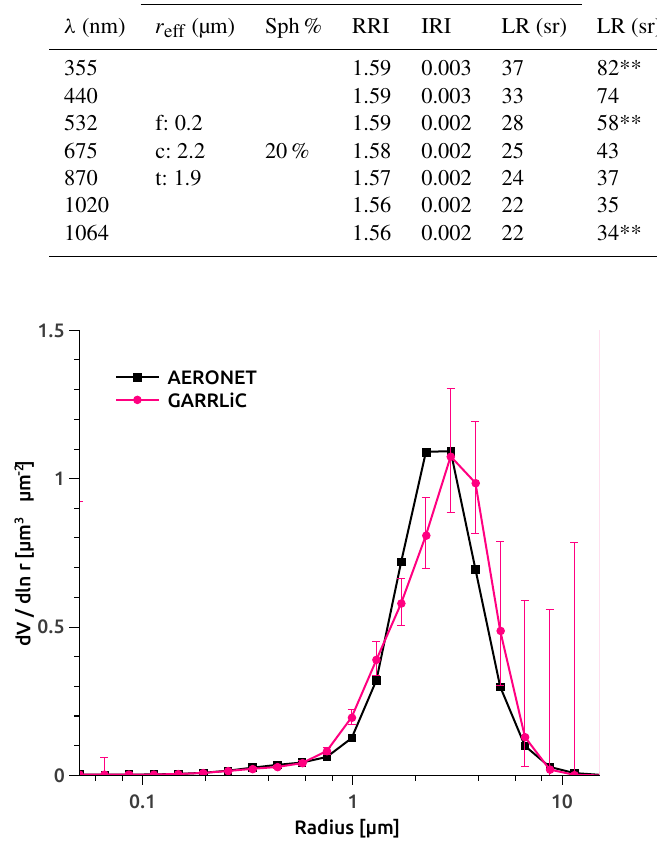
Figure 7. GARRLiC (pink) and AERONET (black) SD on 29 March 2015 (16:49UTC) over the Dakar site (AOD 440nm ≈ 1 . 35 ± 0 . 20 ; α ≈ − 0 . 04 ± 0 . 01).